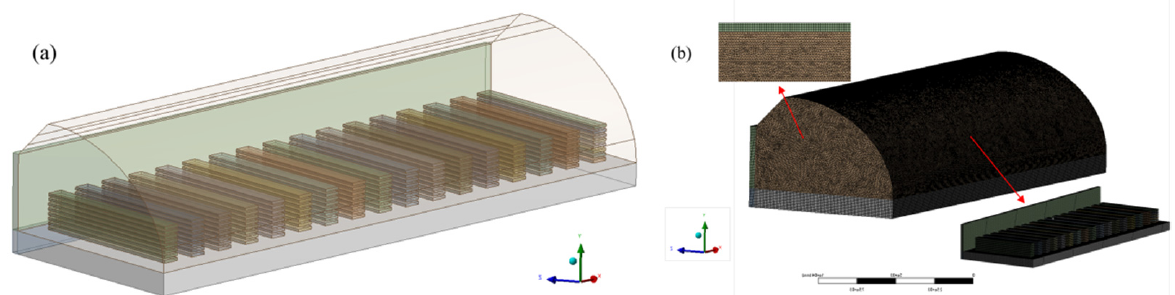
Figure 3. Geometry and grid model of the mushroom solar greenhouse: ( a ) geometric configuration; ( b ) grid division.